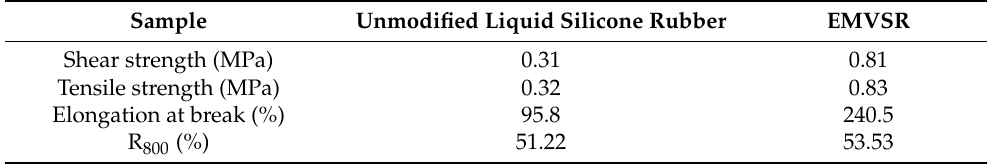
Table 1. The properties of unmodified silicone rubber and EMVSR